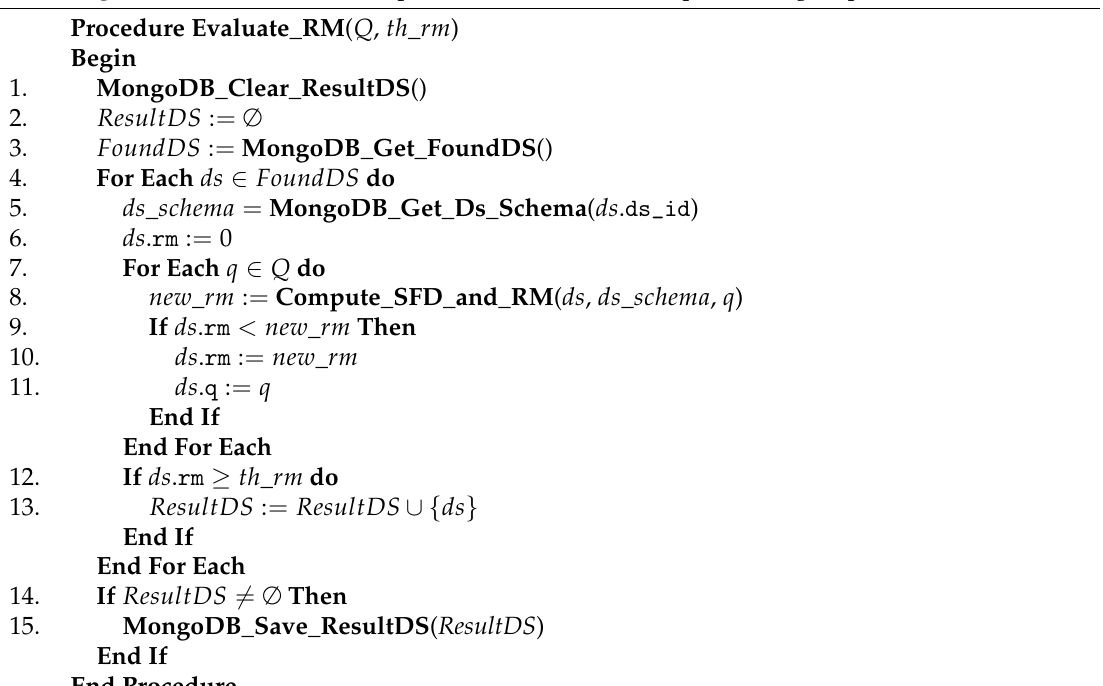
Algorithm 3: Pseudo-code of procedure Evaluate_RM , performing Step